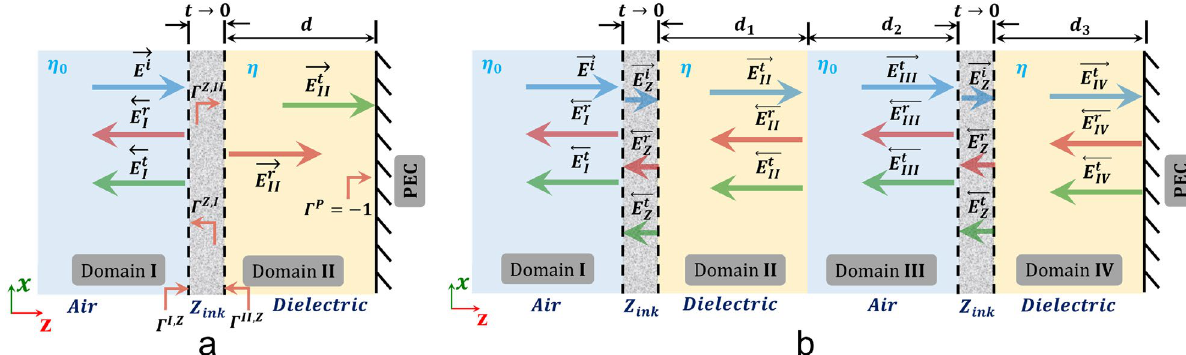
Figure 2. Schematic diagram of media coated with a resistive layer of Z ink impedance. ( a ) Homogeneous medium with one dielectric layer. ( b ) Inhomogeneous medium with two dielectric layers and one air